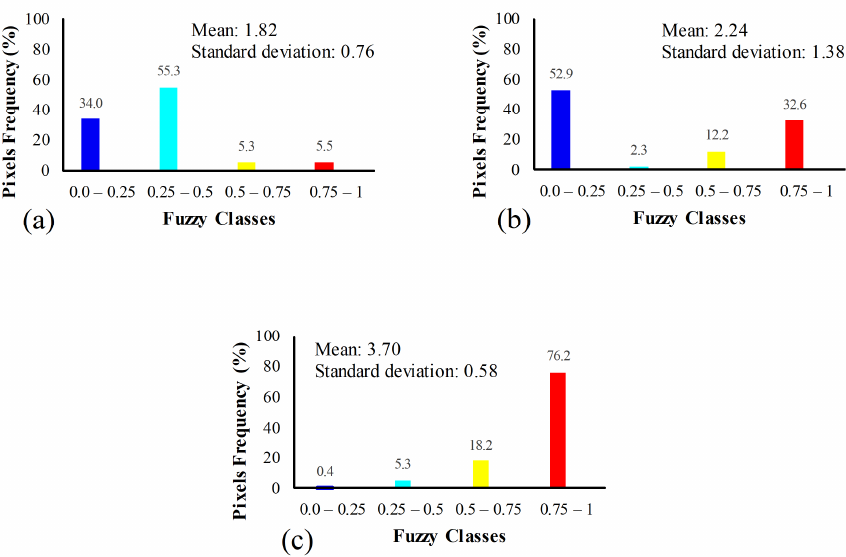
Figure 6. Pixels frequency for each fuzzy class. ( a ) Land use and occupation; ( b ) soil classes; ( c ) proximity to water masses. According to the Group 01 pixels frequency results, the slope variable presented the highest pixels percentage (98.3%) in the less prone to vulnerability fuzzy class (0.0 to 0.25), which was followed by the dry period average maximum rainfall variable (45.1%). The other variables presented values that are below 29.9% for the less prone to vulnerability fuzzy class.